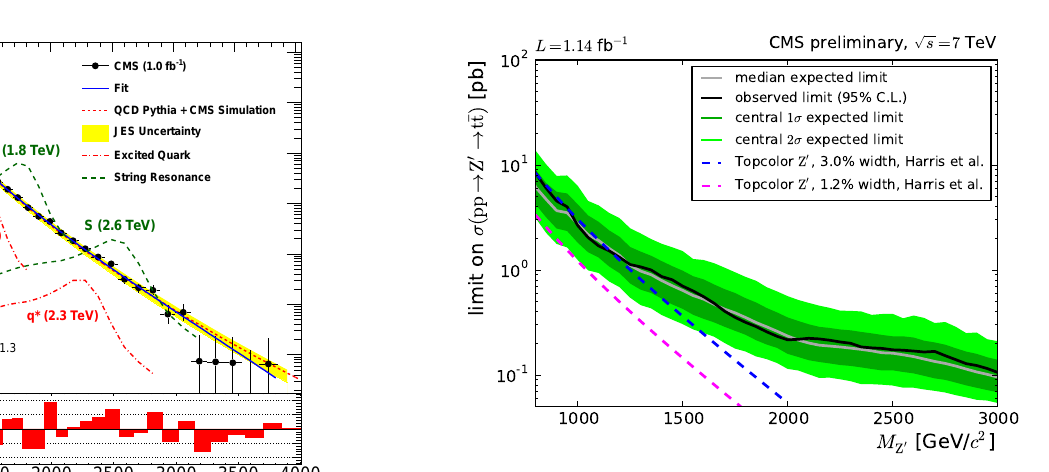
Fig. 7. Expected and observed 95% CL upper limits on σ ( pp